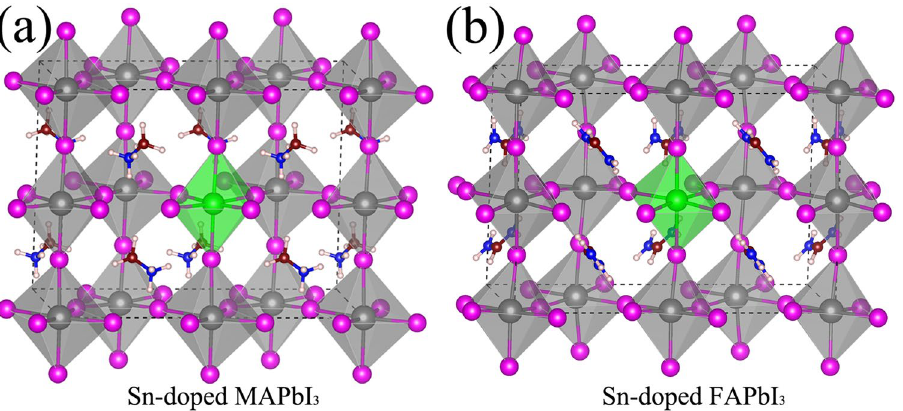
Figure 1. The relaxed atomic structures of the ( a ) Sn-doped MAPbI 3 and ( b ) Sn-doped FAPbI 3 . The silver, violet, blue, brown, pink, and green balls represent Pb, I, N, C, H, and Sn atoms,